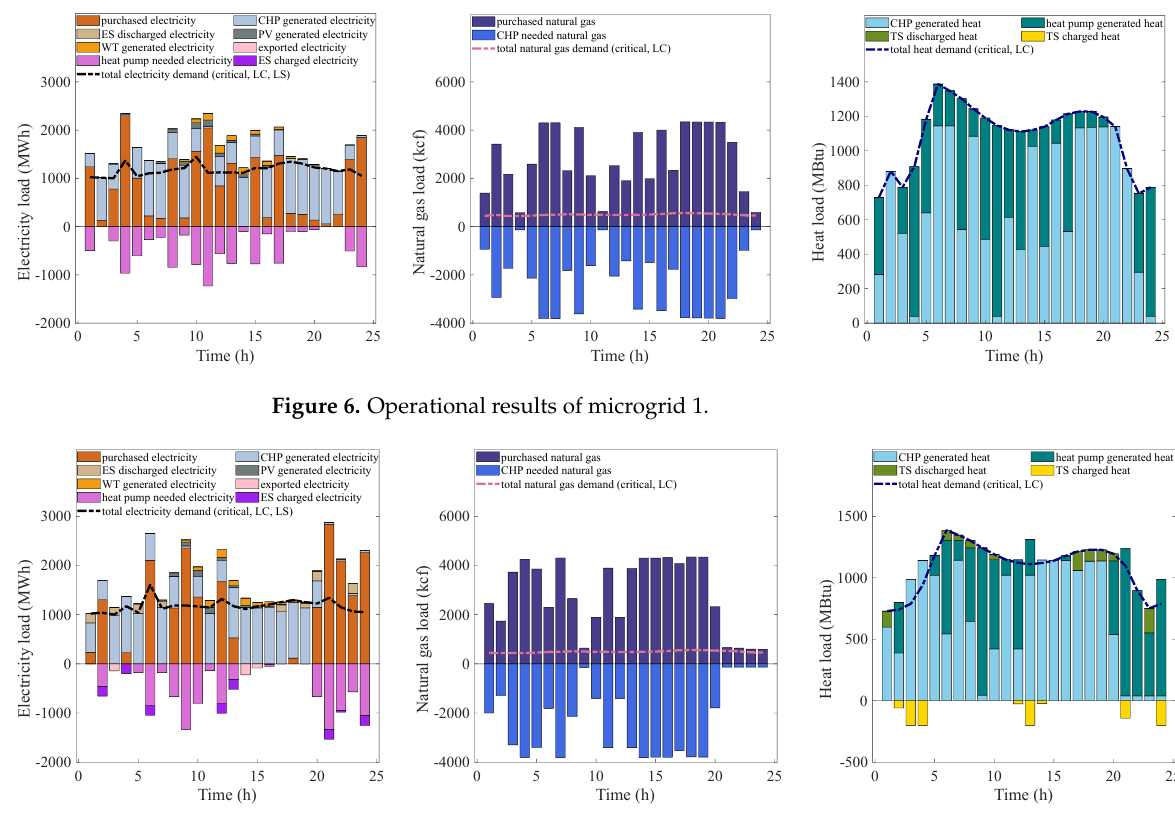
Figure 7. Operational results of microgrid 2.